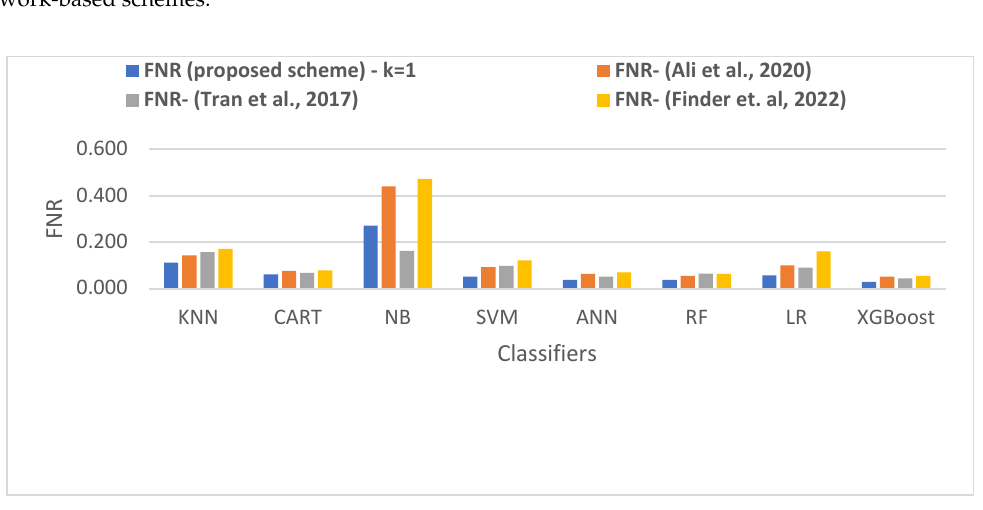
Figure 9. The comparison of the FPRs between the proposed DIEBD-based scheme and the related work-based schemes.